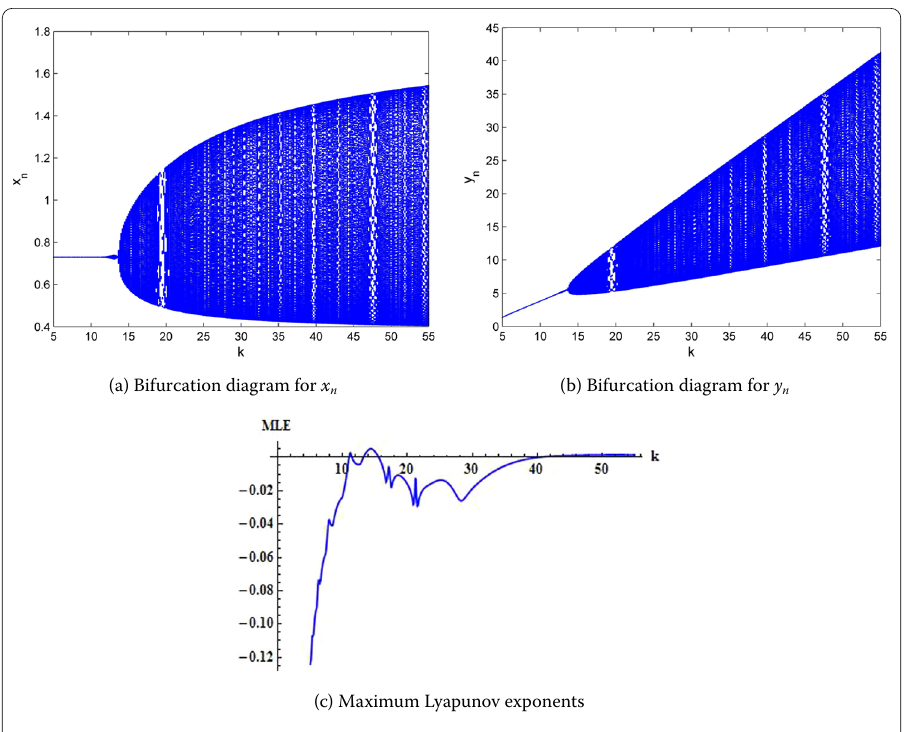
Figure 8 Bifurcation diagrams and MLE for system (1.3) with p = 7.3, q = 4.6, k ∈ [5,55], and ( x 0 , y 0 ) =